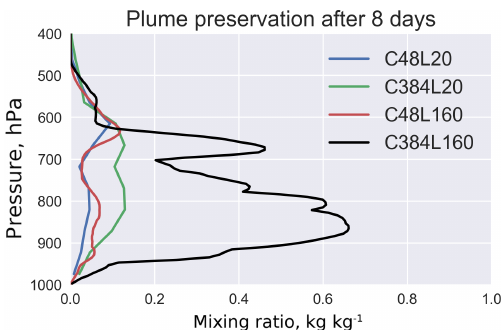
Figure 5. Vertical profile of the maximum mixing ratio for each model vertical level after 8 days of simulation, at low model resolu- tion (C48L20), high model resolution (C384L160) and intermediate cases where only horizontal resolution or vertical resolution is in- creased from the low-resolution case (C384L20,